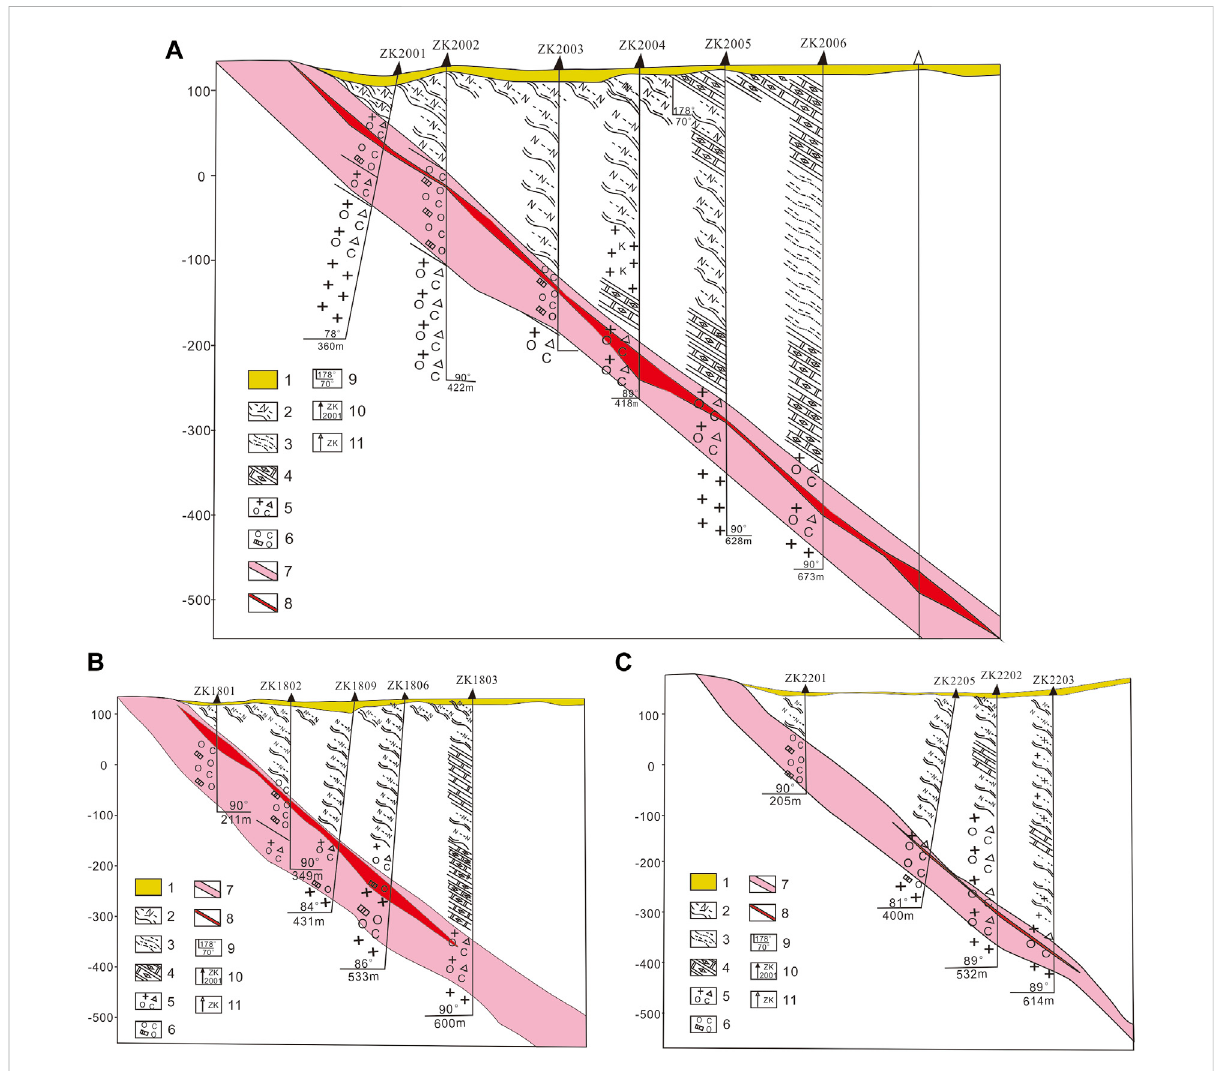
FIGURE 9 Geological pro fi le of exploration in Shanhou gold deposit. (A) Line 20; (B) Line 18; (C) Line 22; 1- Quaternary; 2- Archean plagioclase gneiss; 3- Archean biotite granulite; 4- Paleoproterozoic dolomitic marble; 5- Sericitized cataclastic granite; 6- Pyrite sericite quartz; 7- Alteration zone; 8- gold bodies; 9- Occurrence inclination ; 10- Completed drilling; 11- Recommended dip